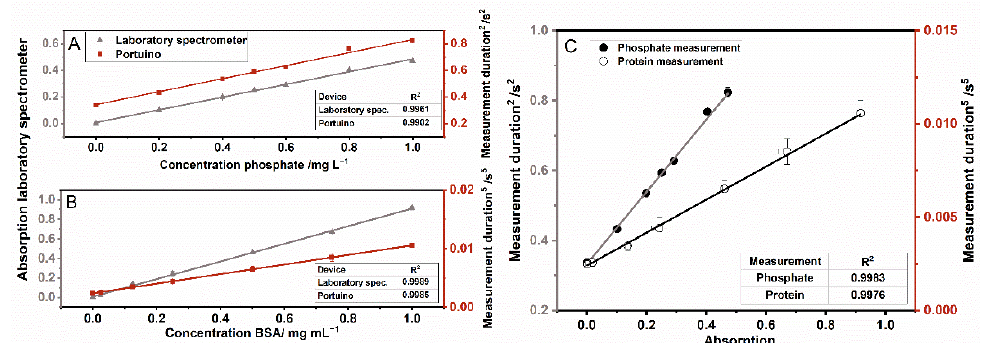
Figure 5. Absorption and measurement duration (squared ( A ) or to the power of 5 ( B )) for phosphate measurement in water ( A ) and protein measurement in water with the Bradford method ( B ) with a laboratory spectrometer (grey, triangles) and the Portuino (red, squares). The absorption has been measured at 590 nm for both devices. The agreement of data was determined with the Portuino and a laboratory spectrometer ( C ). Agreement for phosphate measurement (black, circles) was performed with the help of a commercial test kit and, for the protein measurement of BSA, with the Bradford method (black, not filled circles). n = 3, the error bars are partially hidden by the symbols.